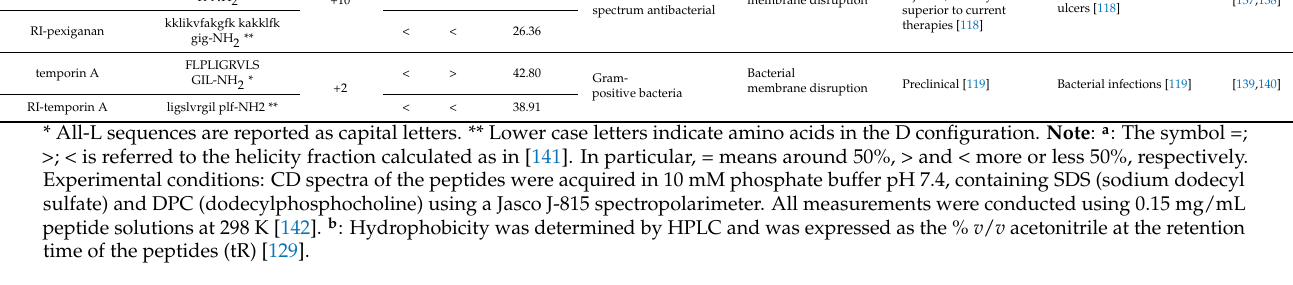
Table 3. MIC values ( µ g/mL) of anti-microbial peptides and of their retro-inverso analogues against reference strains of microorganisms [143]. Taken from reference